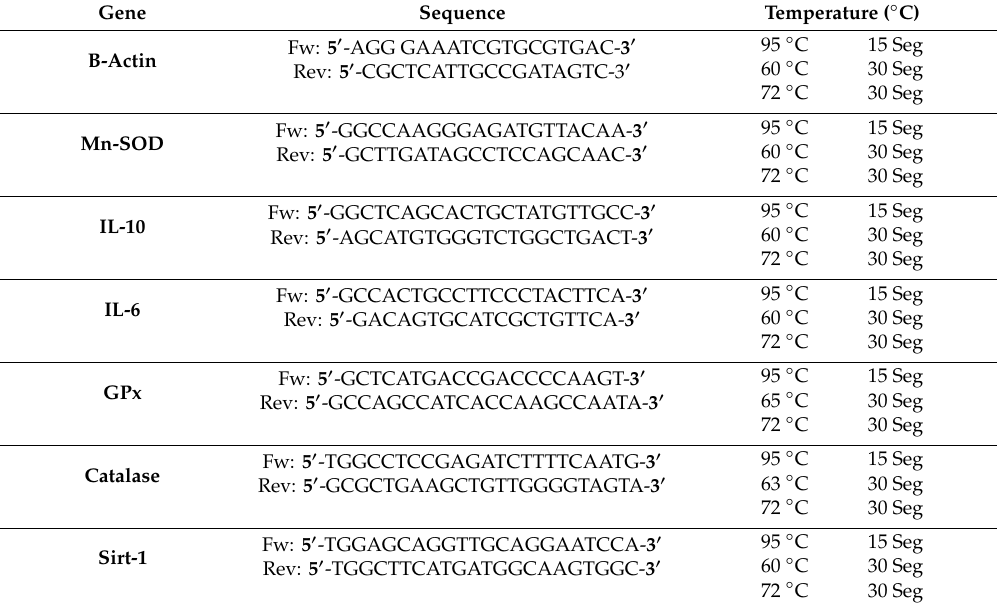
Table 1. Primers sequences and Real-Time PCR